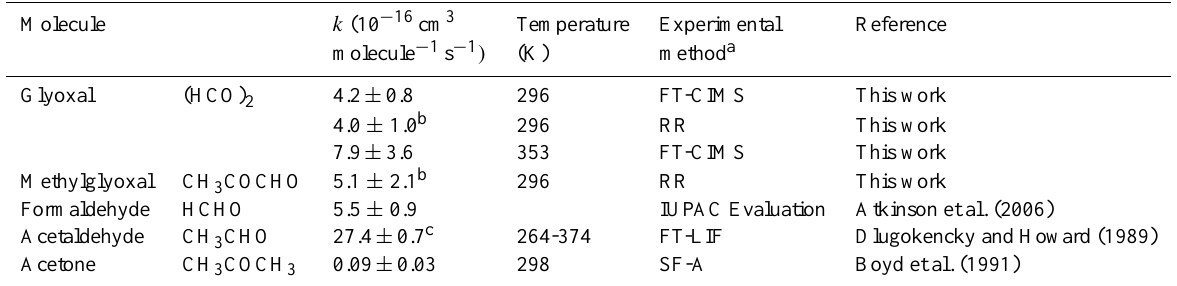
a FT-CIMS: flow tube – chemical ionization mass spectrometry; RR: relative rate study; FT-LIF: flow tube – laser induced fluorescence detection of NO coupled with NO 3 absorption measurement using a multi-pass cell. b Relative to